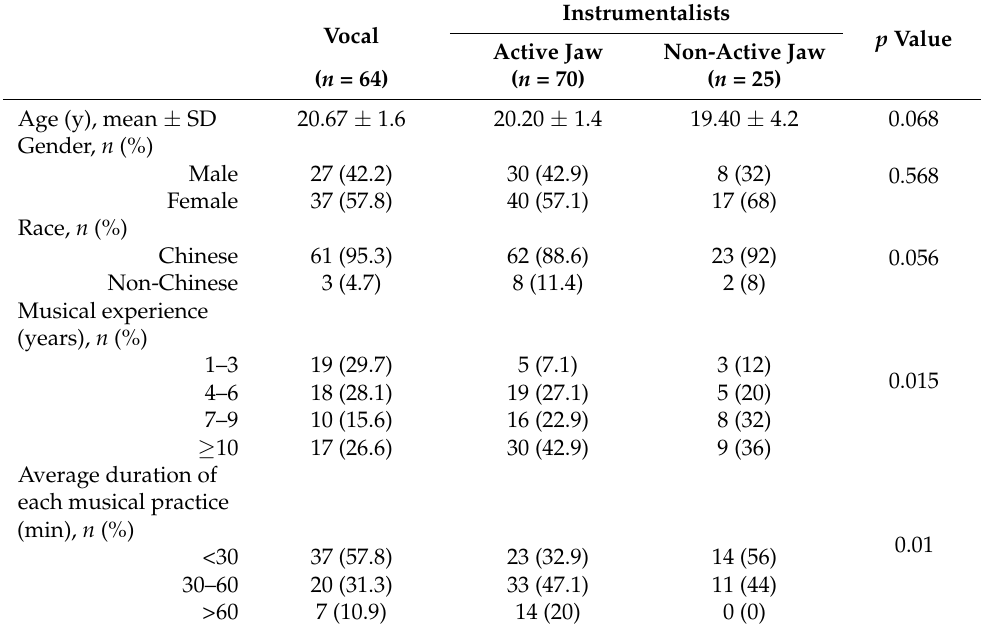
Table 2. Comparison of demographic and musical practice related co-variates among the 3 different musician